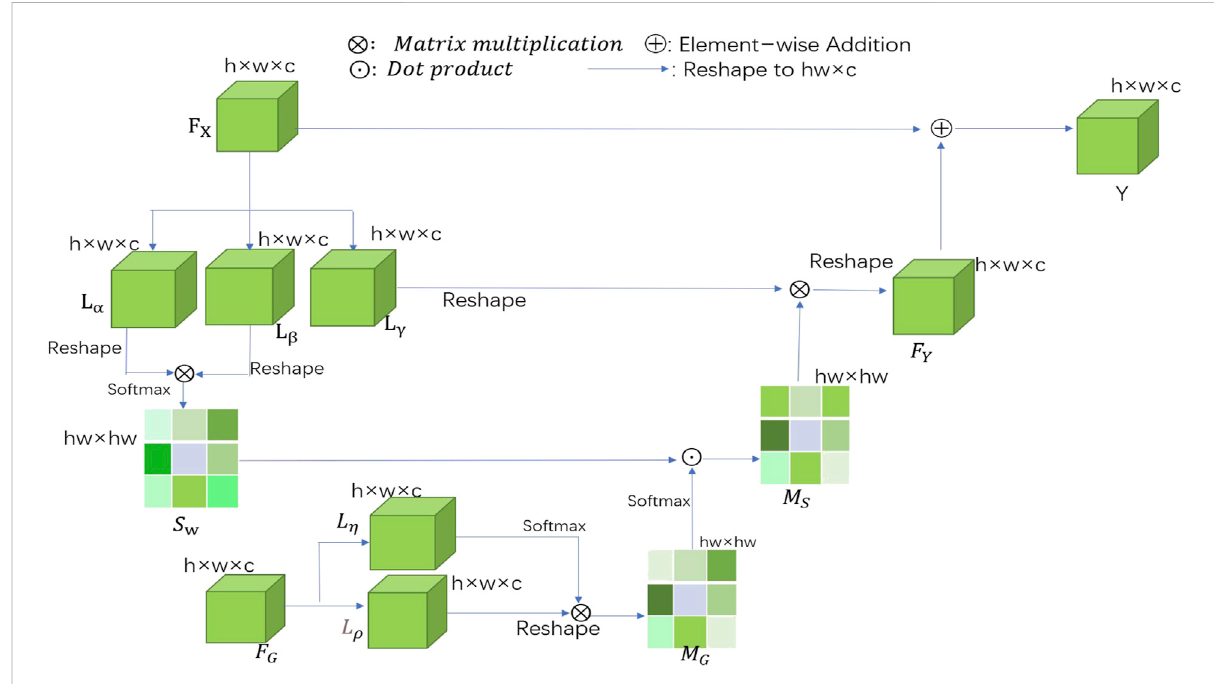
FIGURE 2 Schematic illustration of the details of spatial-wise GGB, where F G is the guidance map and F X is the input feature